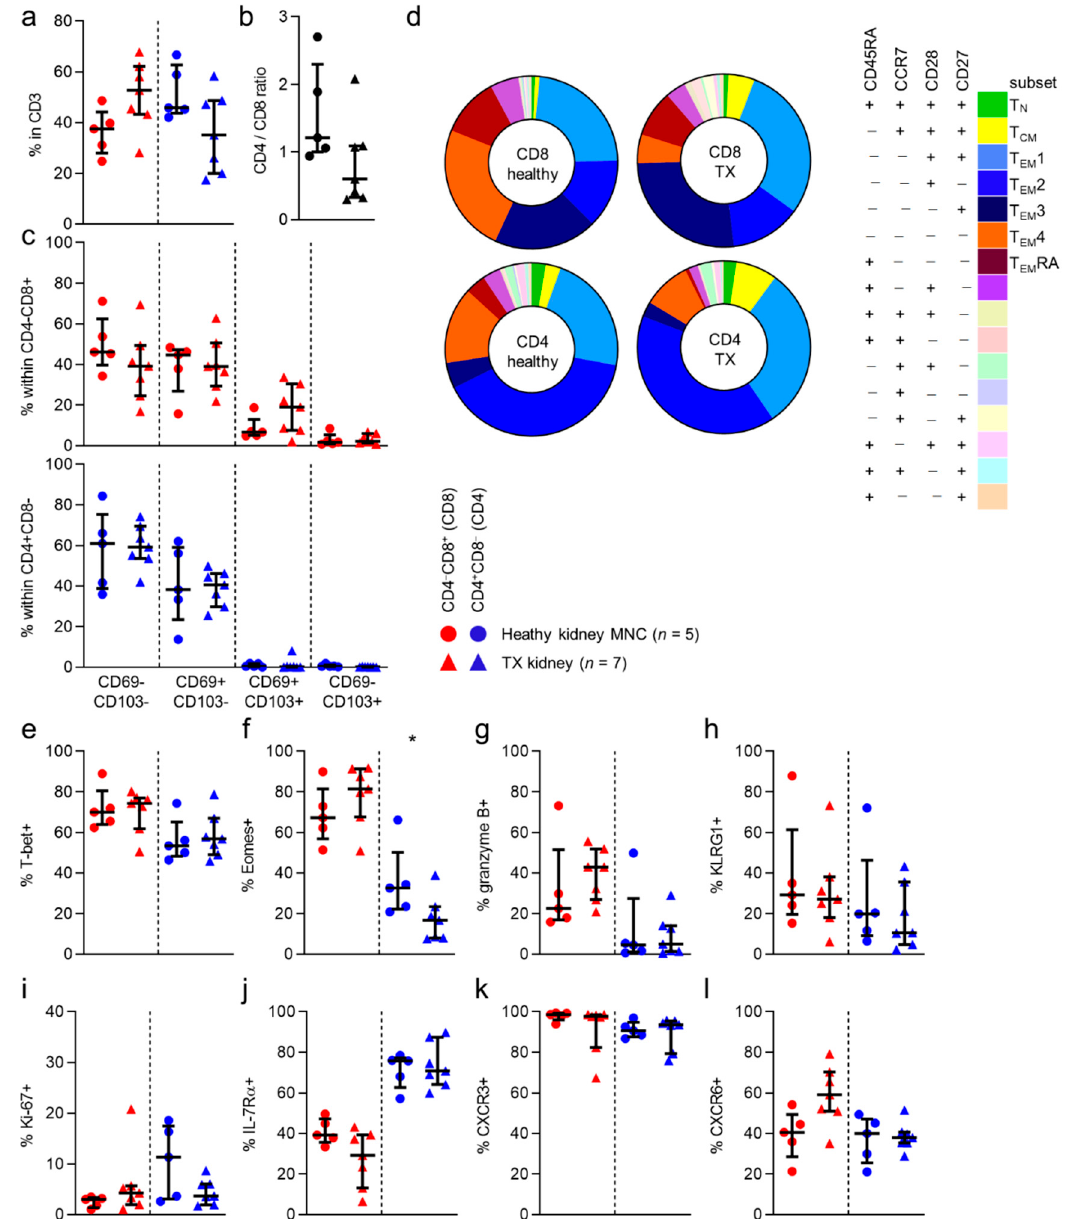
Figure 3. No differences in phenotype between healthy kidney and allograft T cells.( a ) Percentage of CD4 − CD8 + (CD8) and CD4 + CD8 − (CD4) T cells within CD3 + CD45 + single-cell live lymphocytes from healthy kidney compared to transplanted (TX) kidney (median with IQR in black). ( b ) CD4/CD8 ratio within PB and healthy kidney-derived T cells. ( c ) Distribution of CD69/CD103 based subsets within CD8 and CD4 T cells (median with IQR in black) derived from healthy and TX kidney (median with IQR in black). ( d ) Expression patterns of CD27, CD45RA, CCR7 and CD28 within CD8 and CD4 T cells from healthy kidney and TX (transplanted) kidney (median). ( e – l ) Comparison of expression of T-bet ( e ), Eomes ( f ), granzyme B ( g ), KLRG1 ( h ), ki-67 ( i ), IL-7R α ( j ), CXCR3 ( k ) and CXCR6 ( l ) in CD8 (red) and CD4 (blue) T cells derived from healthy kidney and TX kidney (median with IQR in black). Mann-Whitney U-test was used for statistical comparison. Only significant p -values are displayed: * p <0.05.